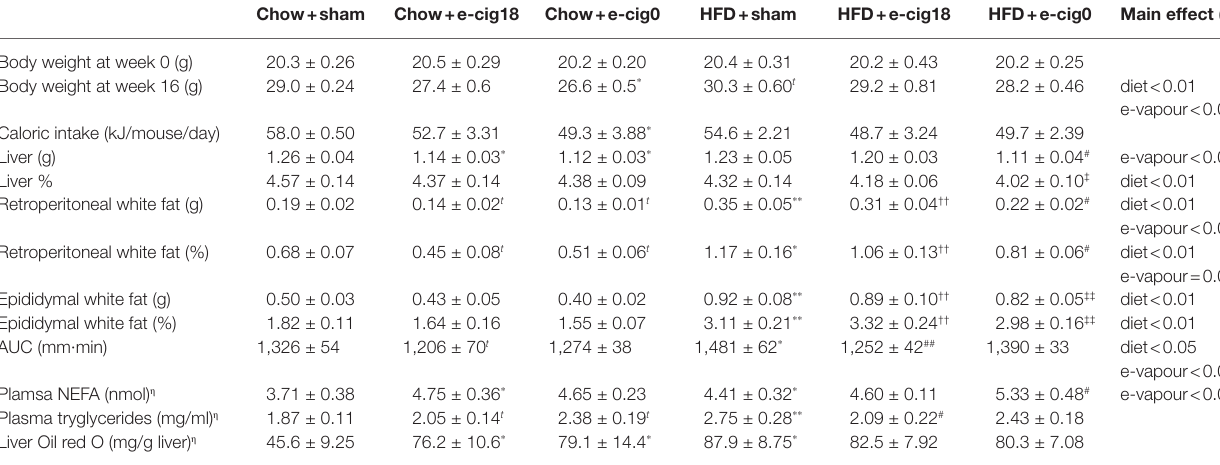
TABLE 1 | Metabolic